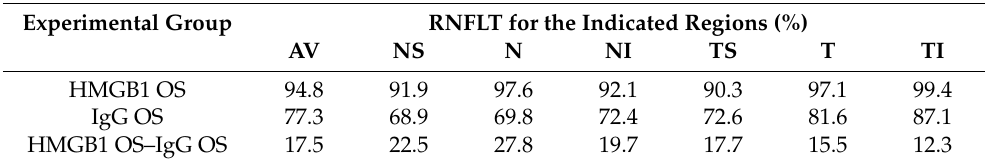
Table 1. Summary of OCT analysis including RNFLTs of the IgG OS and HMGB1 groups and their differences. Experimental Group RNFLT for the Indicated Regions